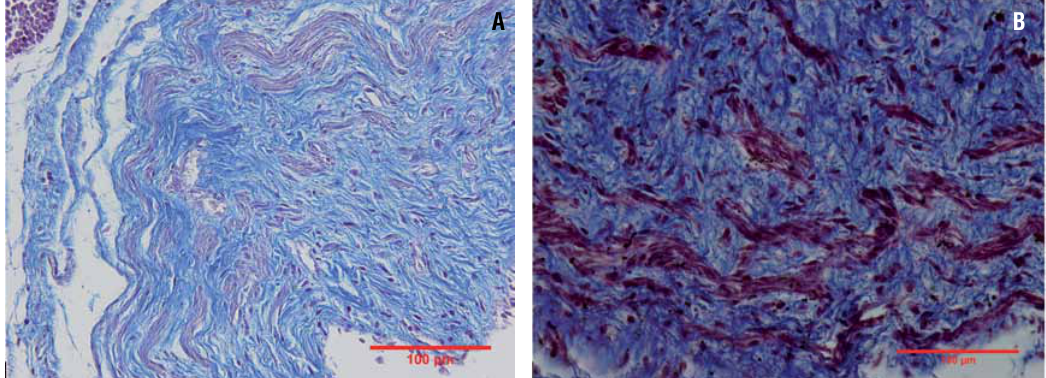
Figure 3 - Photomicrographs showing smooth muscle. A) Normal fetal ureter with 20 WPC. Masson’s trichrome X400. B) Ureter of fetus with anencephaly with 20 WPC. Masson’s